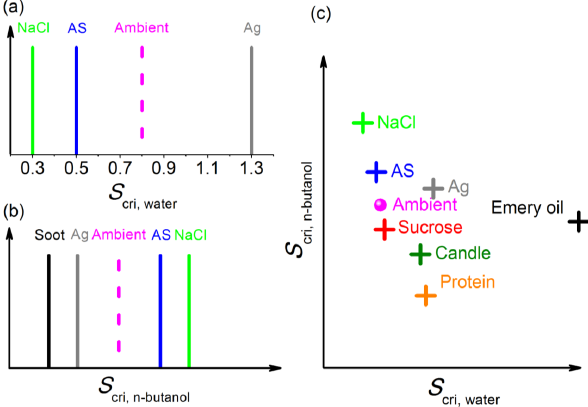
Figure 11. Critical supersaturations ( S cri ) for various chemical compounds in different working fluids: (a) water and (b) n -butanol. (c) Schematic of 2-D solvoscopicity distribution matrix. The data set is collected from the previous studies (Hermann et al.,